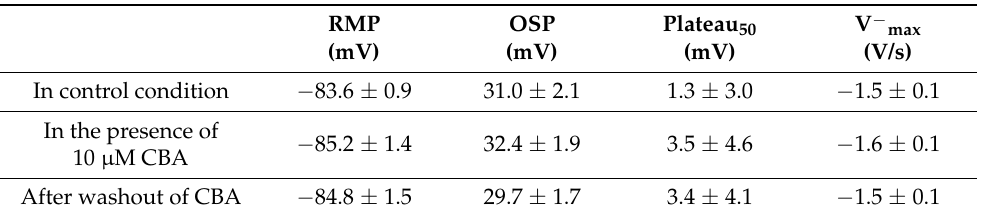
Table 1. Unaltered AP parameters by CBA recorded from eight individual cells obtained from six